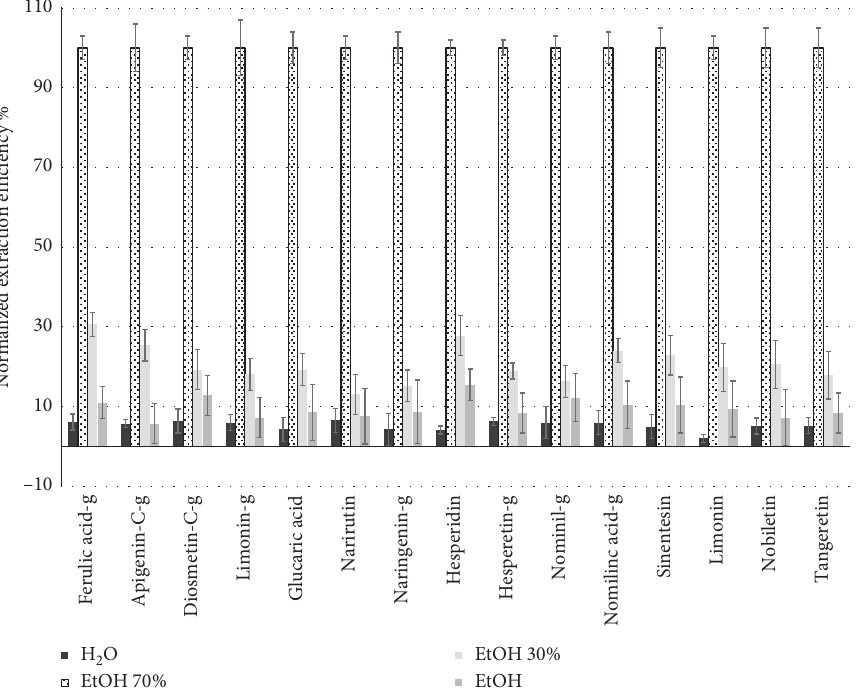
Figure 3: Normalized extraction efficiency of target analytes using different elution solvents. Values are means of three replicates ± relative standard deviation